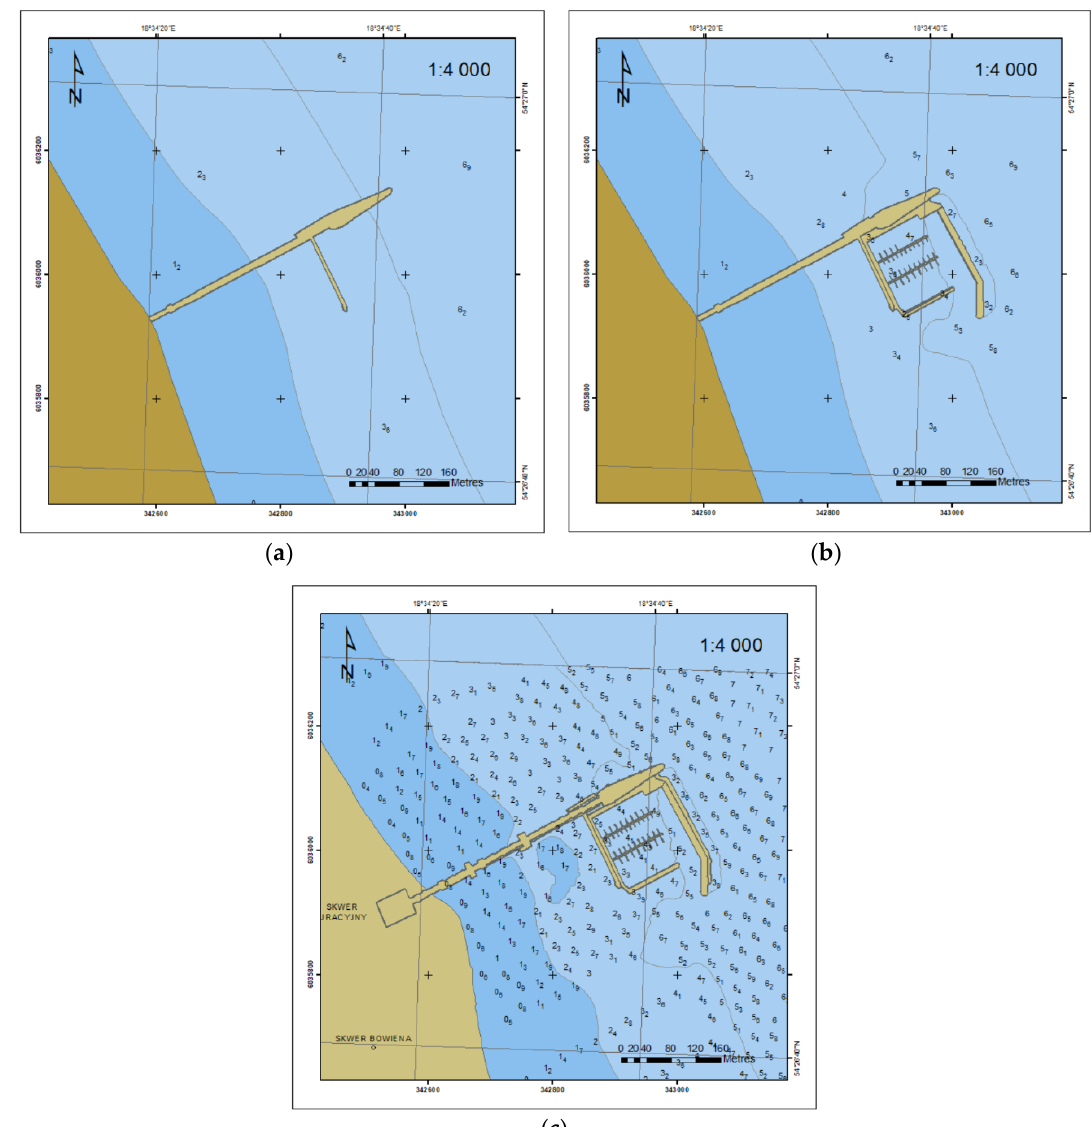
Figure 4. Evolution of Electronic Navigational Chart (ENC) content in 2011 ( a ), 2014 ( b ) and 2018 ( c ).